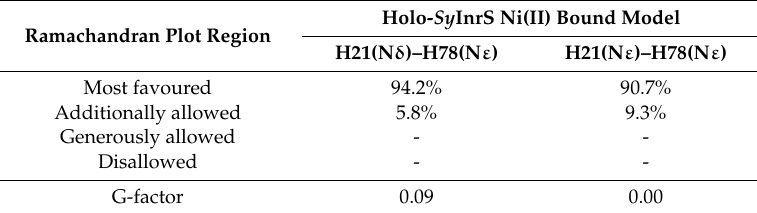
Table 3. Analysis of the metal binding sites in the Sy InrS Ni(II) bound models.